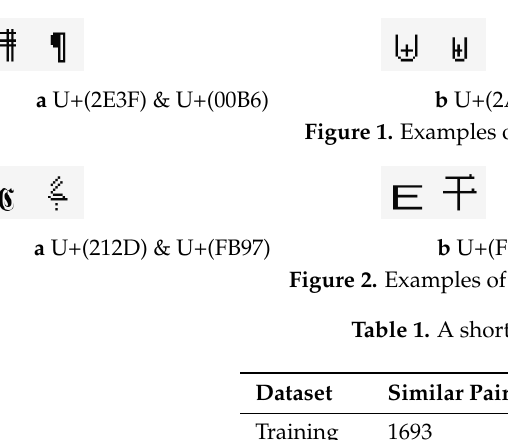
Figure 1. Examples of Visually Similar Characters.